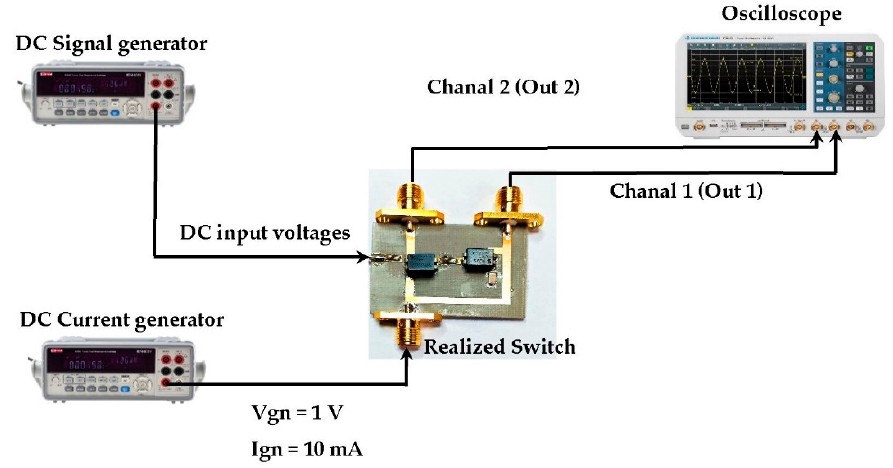
Figure 24. Measurement prototype of the output currents for the first and second outputs of the proposed switch.